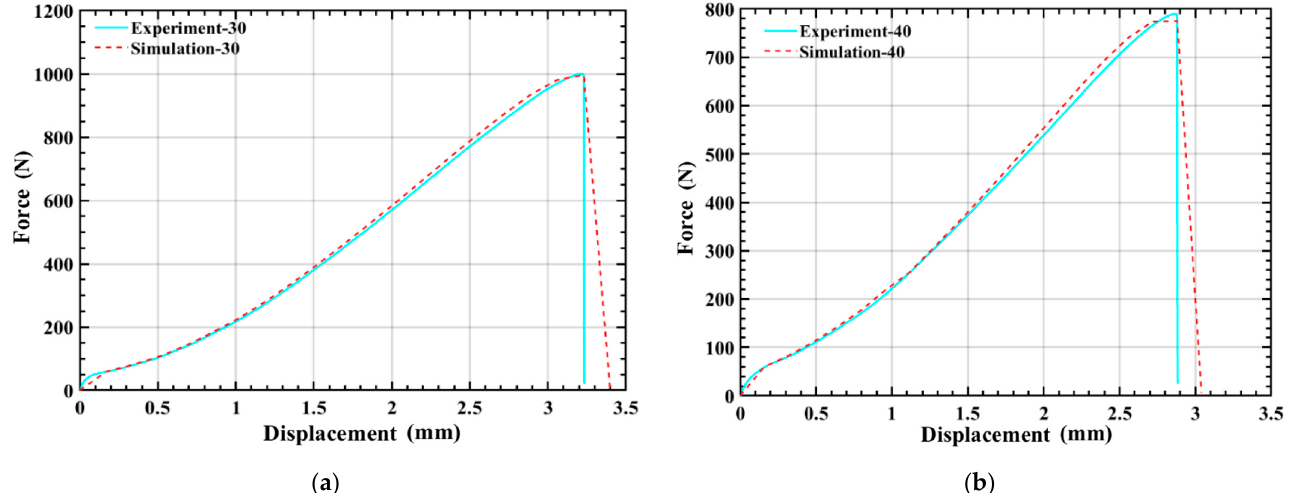
Figure 4. Force-displacement relationships of 3D printed PLA under uniaxial tension at temperature of ( a ) 30 °C and ( b ) 40 °C. Table 1. Experimental parameters of FFF 3D printed PLA tensile samples.